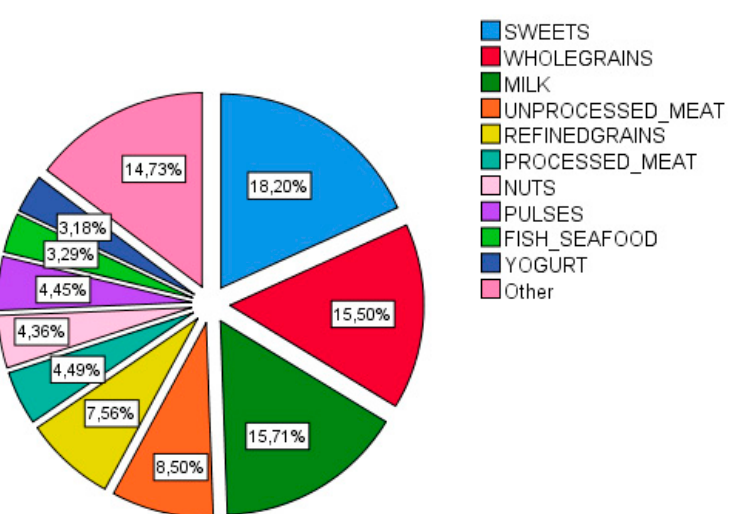
Figure 3. Pie chart showing top food categories contributing to dietary CML intake